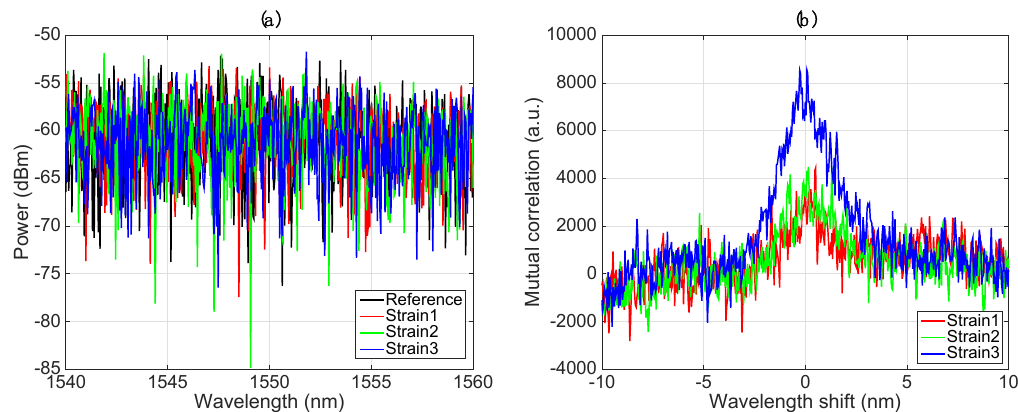
Figure A1. ( a ) Scattering traces of a MgO-NP fiber (reported, for visualization purposes, on the 1540–1560 nm range), in reference conditions and for 3 different values of strain. ( b ) Mutual correlation of the reference signature with the signatures acquired for the 3 strain values.